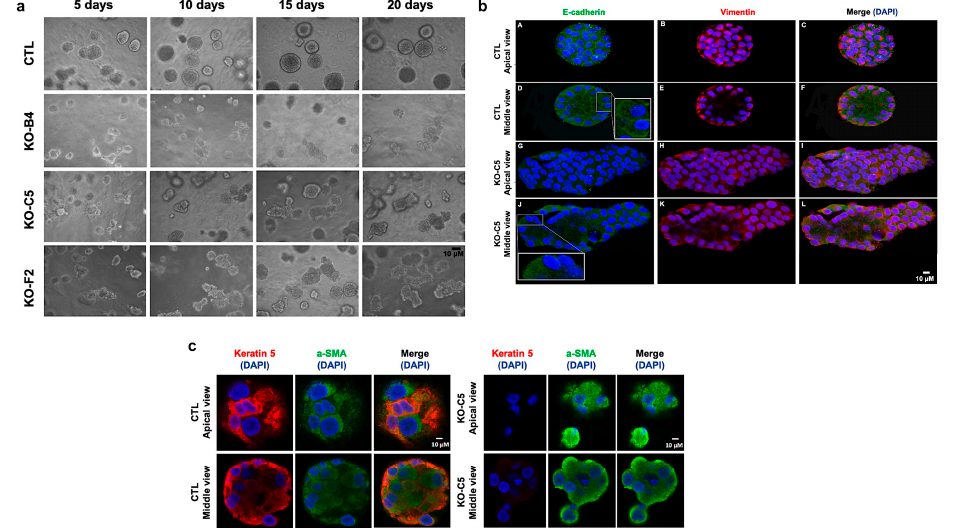
Figure 2 . CYLD inactivation compromises the proper development of MCF10A mammospheres. ( a ) Control (CTL) and CYLD-deficient MCF10A cells (KO-B4, KO-C5, and KO-F2) were cultured in the presence of Matrigel for 20 days and photographed. ( b ) Expression pattern of E-cadherin (green) and vimentin (red) in control and CYLD-deficient MCF10A clones cultured in the presence of Matrigel for 20 days. The cell nuclei were stained with 4 ′ ,6-diamidino-2-phenylindole (DAPI) (blue). Inset images represent 200× magnification of the corresponding areas. ( c ) Expression pattern of keratin-5 (red) and smooth muscle actin ( α -SMA, green) in control and CYLD-deficient MCF10A clones cultured in the presence of Matrigel for 20 days. The cell nuclei were stained with DAPI (blue). Representative data from one out of two independent experiments are